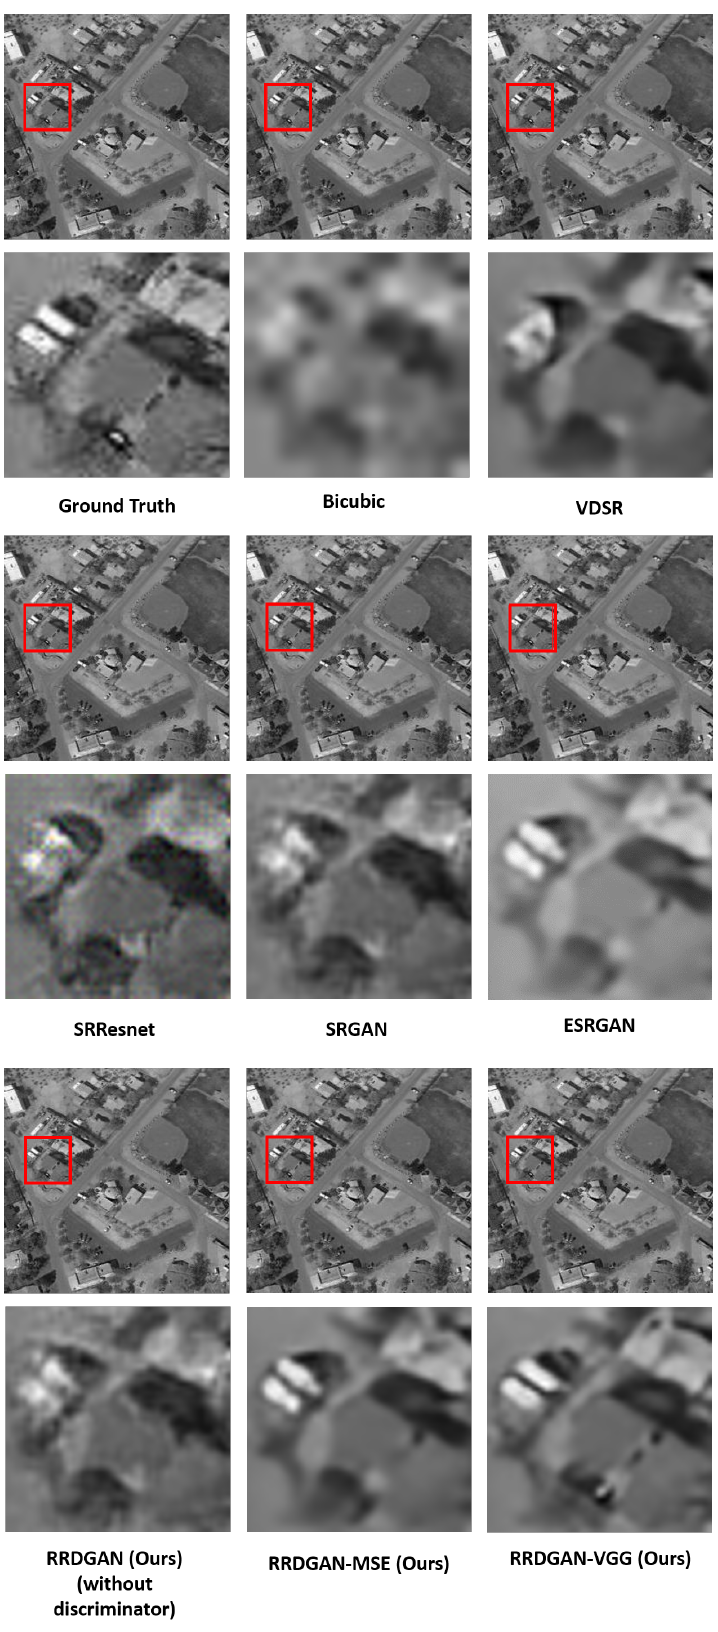
Figure 9. Comparison results among different methods of “BaseballDiamond”, scale factor is